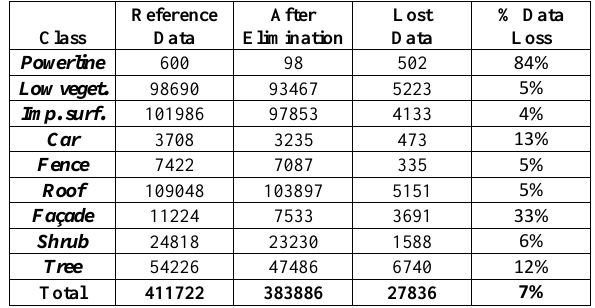
Table 1. Number of points in each evaluation set for each class, before and after elimination.